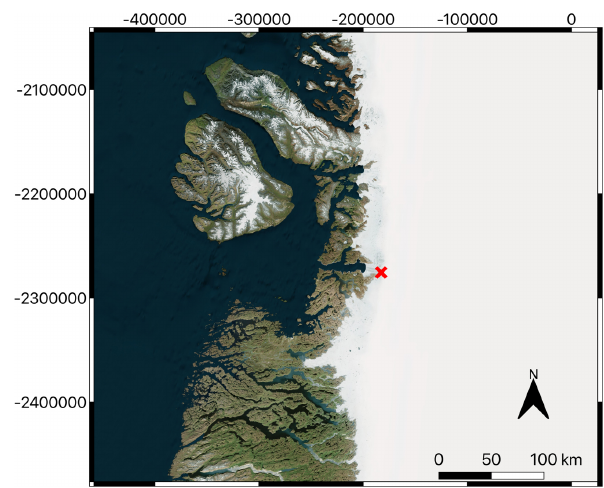
Figure 11. Optical image of the test site at the Jakobshavn Isbræ Glacier in Greenland, where the red cross marks the location of the fast-moving glacier outlet for the validation of the ITS_LIVE Sentinel-1 image-pair products. Background: © Microsoft Bing Maps